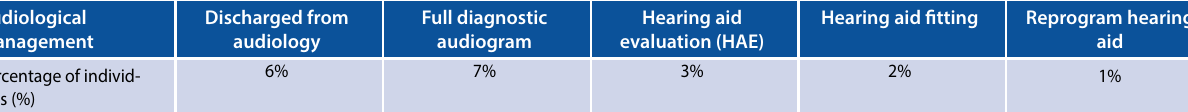
Table 6: Recommendations/suggested audiological management protocols ( n = 124). Audiological